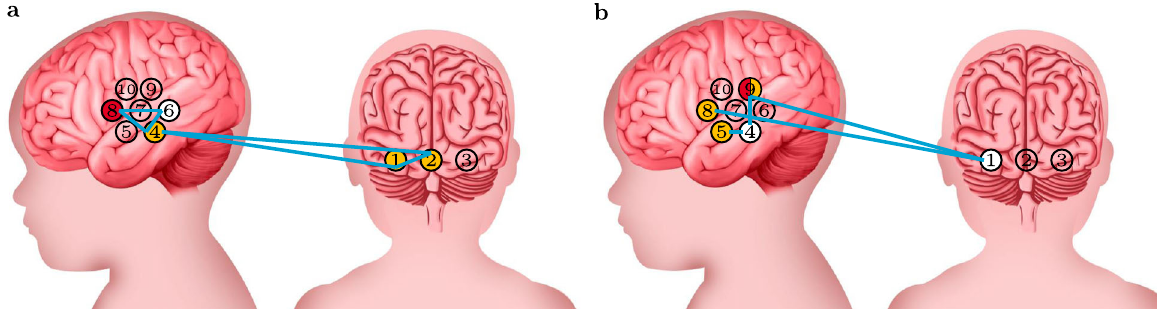
Fig. 2 Patterns of cortical networks delineated by xMVPA. The patterns (cyan) identi fi ed by the xMVPA delineate the contributions between brain regions evoked by a visual and b auditory stimuli. The colour of the channels denotes their level of activity: inactive (white), active (amber), and very active (red), and uncoloured for channels that do not belong to any pattern. Table 1 A comparison of the (Ch) signi fi cance and decoding strength found using correlation-based MVPA Emberson et al. 19 (second row) with the channel activations using conceptual labels (CoLs) of inactive , active , and very active provided by the proposed xMVPA (third row) for the Auditory-Visual (AV) experiment in the study by Emberson et al. 19 . Anatomical